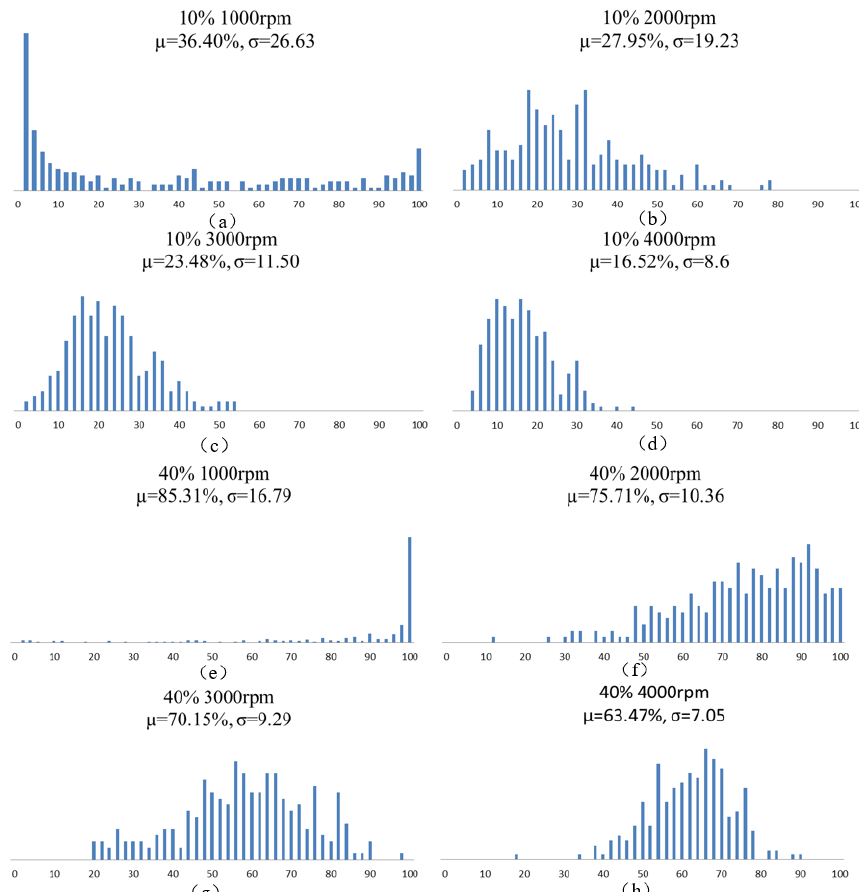
Figure 5. ( a – d ) 10% mass fraction Nd-Fe-B composite uniformity for different fabrication spincoating speed. Histograms represent for samples at given processing parameters. ( e – h ) 40% mass fraction Nd-Fe-B composite uniformity for different fabrication spincoating speed. Histograms represent for samples at given processing parameters.